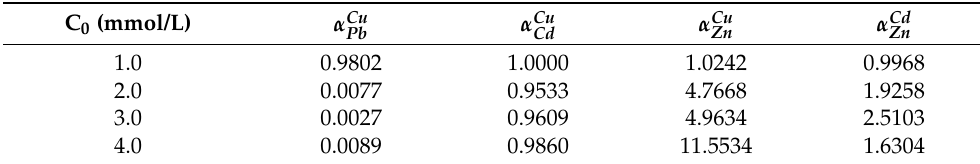
Table 5. Separation factors ( α ) in binary systems at equal molar